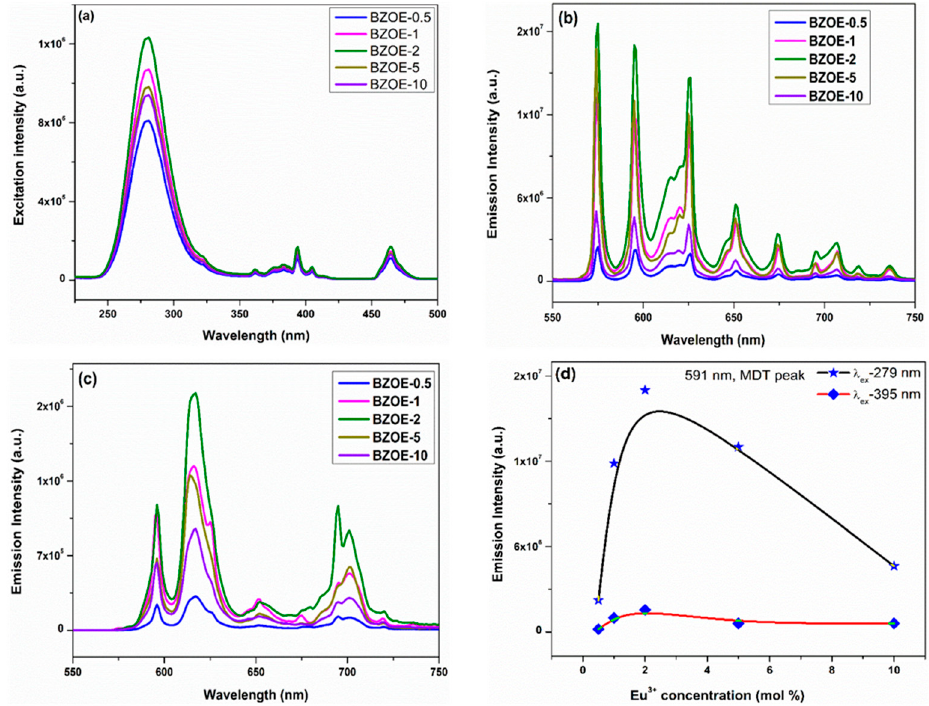
Figure 4. ( a ) Excitation spectra with λ em = 625 nm, emission spectra under ( b ) λ ex = 279 nm and ( c ) λ ex = 395 nm of the BZOE samples. ( d ) Effects of Eu 3+ doping concentration of the BZOE samples on integrated MDT emission intensity of 5 D 0 → 7 F 1 transition.